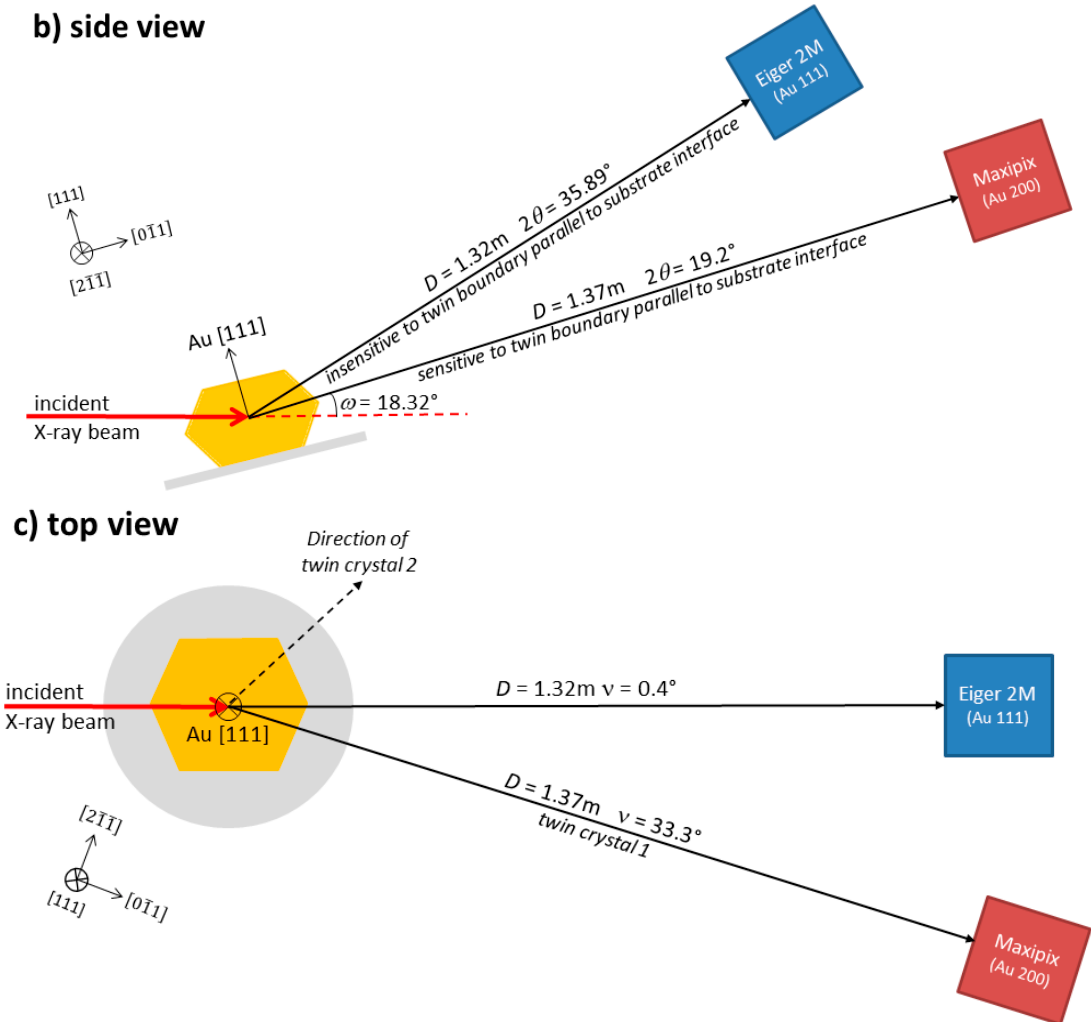
Figure 1. ( a ) Photograph, ( b ) schematic side view, and ( c ) schematic top view of the experimental setup at the ID01 beamline at ESRF using two 2D detectors simultaneously. ω , γ , and 2 θ correspond to the incident angle (similar for the two reflections), and the in-plane and out-of-plane scattering angles.